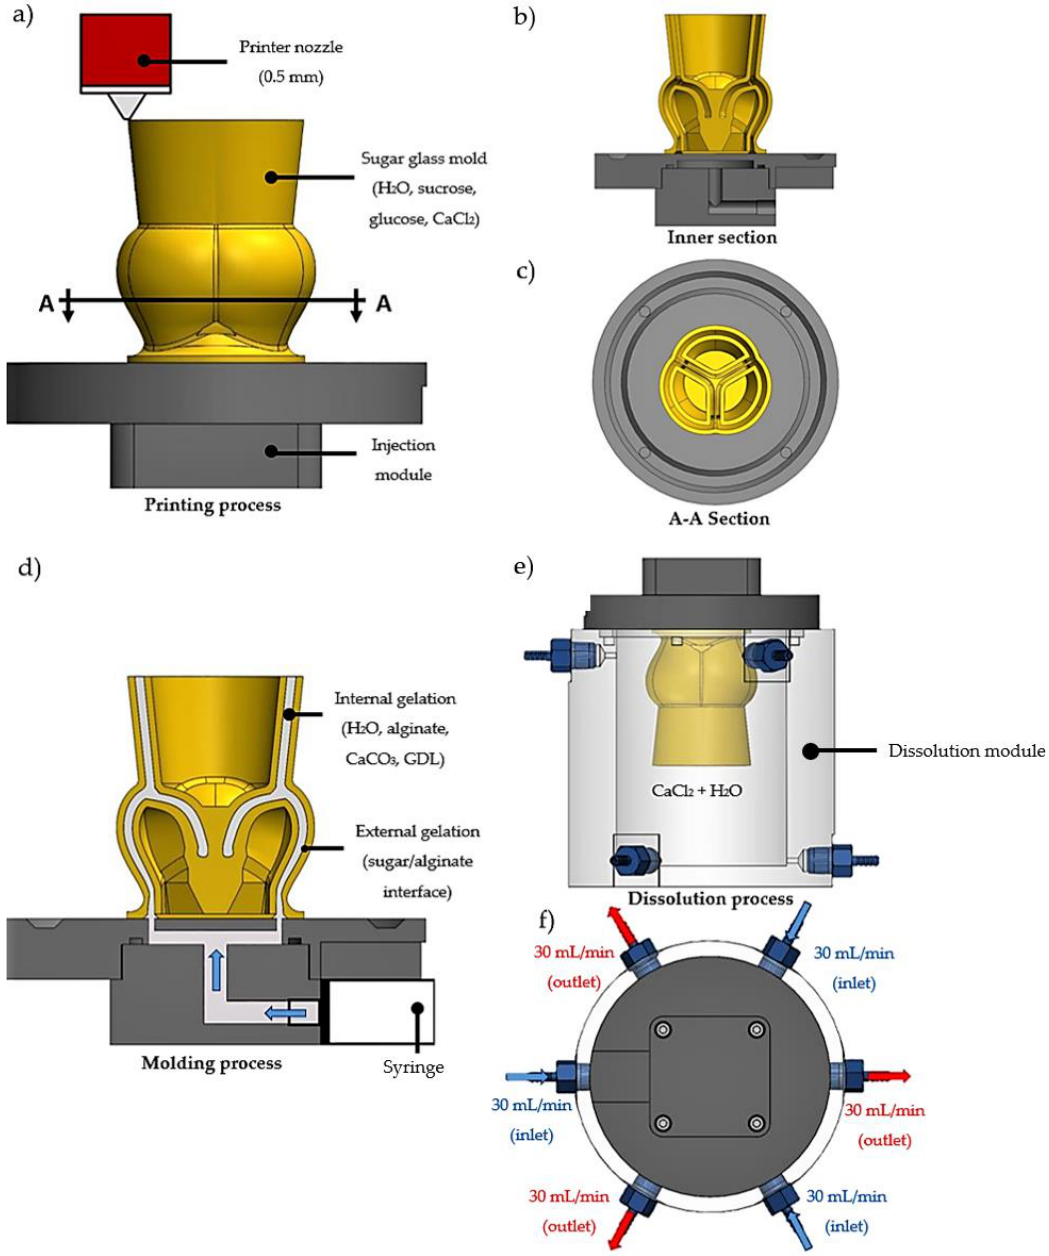
Figure 1. Schematic of the aortic valve scaffold fabrication. ( a ) Aortic valve sugar glass mold loaded with CaCl 2 and printed with a 0.5 mm custom printer nozzle and a 0.2 mm layer height. ( b ) Inner section of the mold. ( c ) A-A section of the mold showing the interior at the mid-sinus. ( d ) Molding process of the aortic valve scaffold using the syringe loaded with the sodium-alginate formulation containing the sodium alginate loaded with GDL and CaCO 3 for internal gelation. External gelation occurred at the sugar/alginate interface. ( e ) Transferring the mold injected with the sodium-alginate solution into the dissolution module. ( f ) For the dissolution of the sugar mold, a 90 mL/min total (inlet/outlet) flow of water supplemented with CaCl 2 was performed.